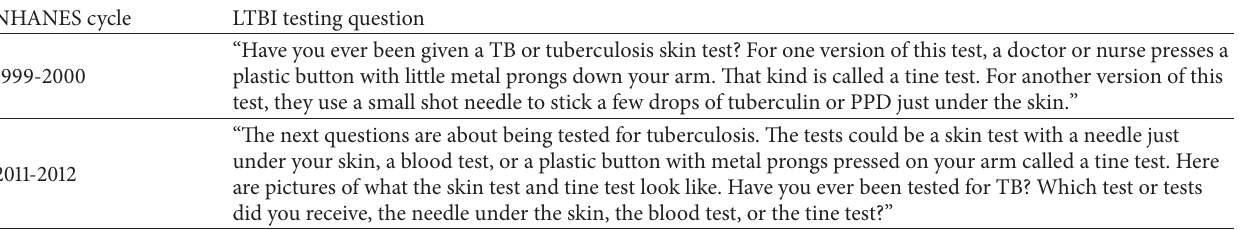
Table 1: Latent TB infection (LTBI) testing questions contained in the 1999-2000 and 2011-2012 National Health and Nutrition Examination Surveys